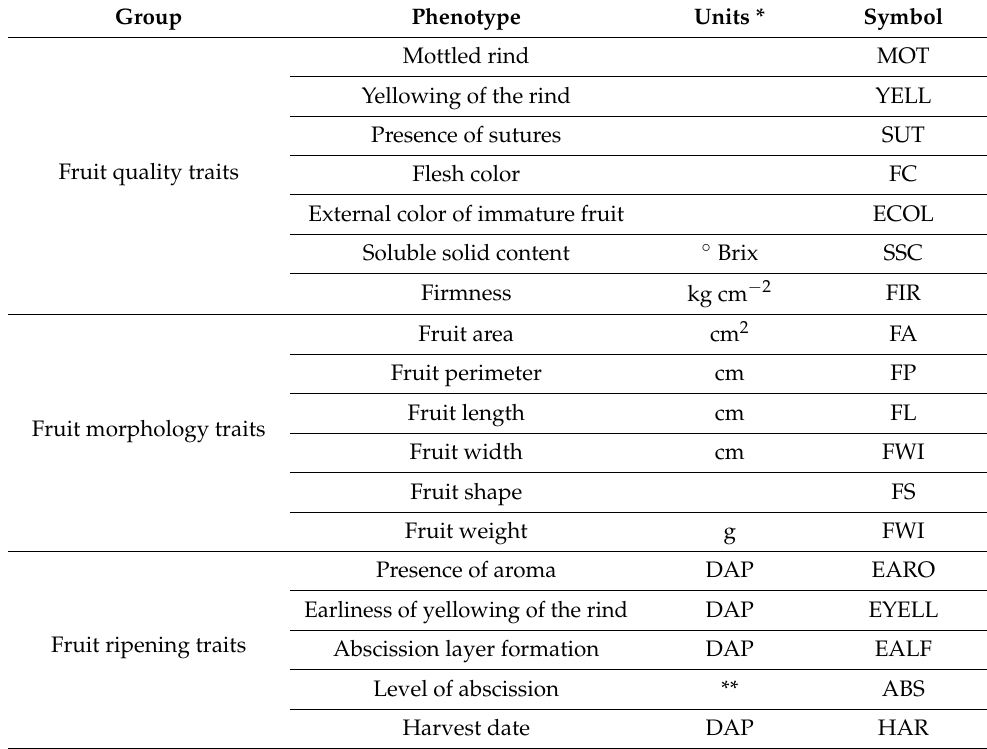
Table 3. Different phenotypes analyzed in this study, divided into three groups. Group Phenotype Units * Symbol Mottled rind MOT Yellowing of the rind YELL Presence of sutures SUT Fruit quality traits Flesh color FC External color of immature fruit ECOL Soluble solid content ◦ Brix SSC Firmness kg cm − 2 FIR Fruit area cm 2 FA Fruit perimeter cm FP Fruit length cm FL Fruit morphology traits Fruit width cm FWI Fruit shape FS Fruit weight g FWI Presence of aroma DAP EARO Earliness of yellowing of the rind DAP EYELL Fruit ripening traits Abscission layer formation DAP EALF Level of abscission ** ABS Harvest date DAP